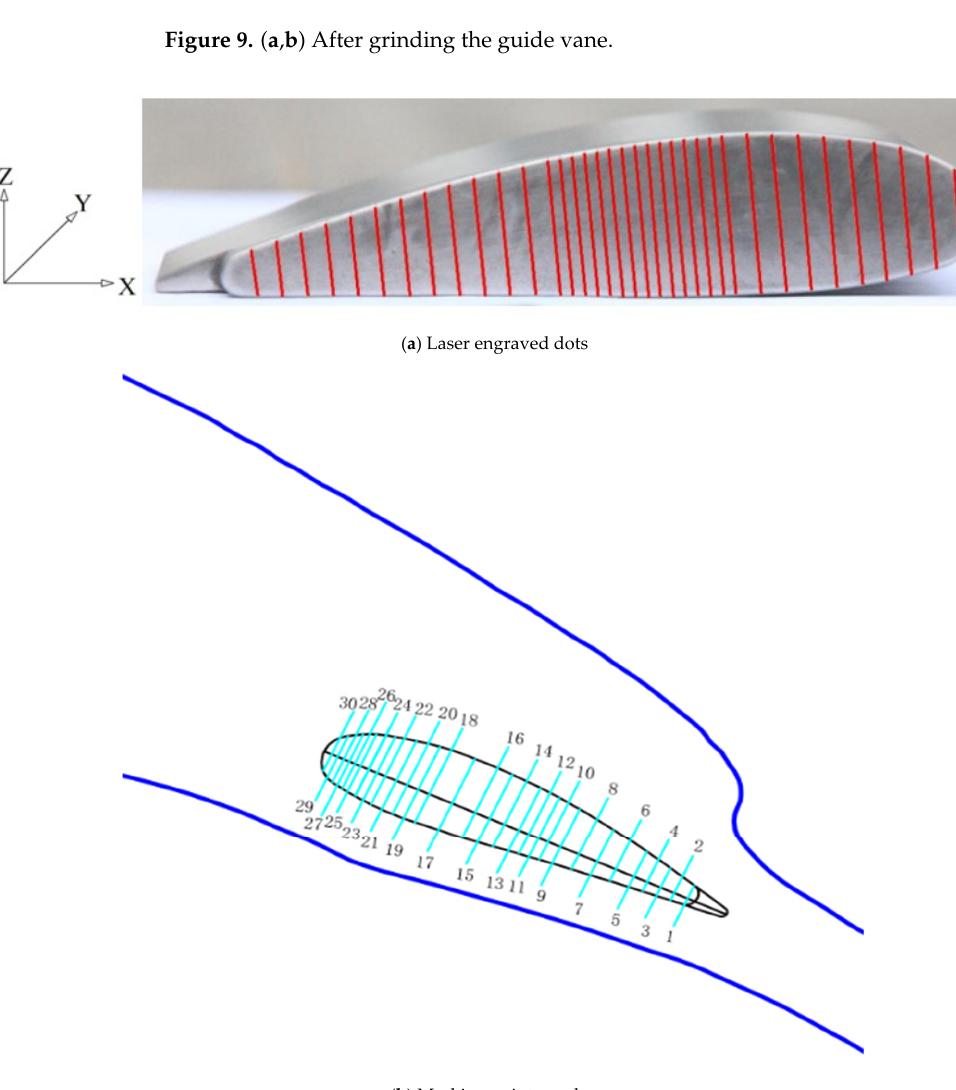
Figure 10. ( a , b ) Laser engraved dots and numbers.